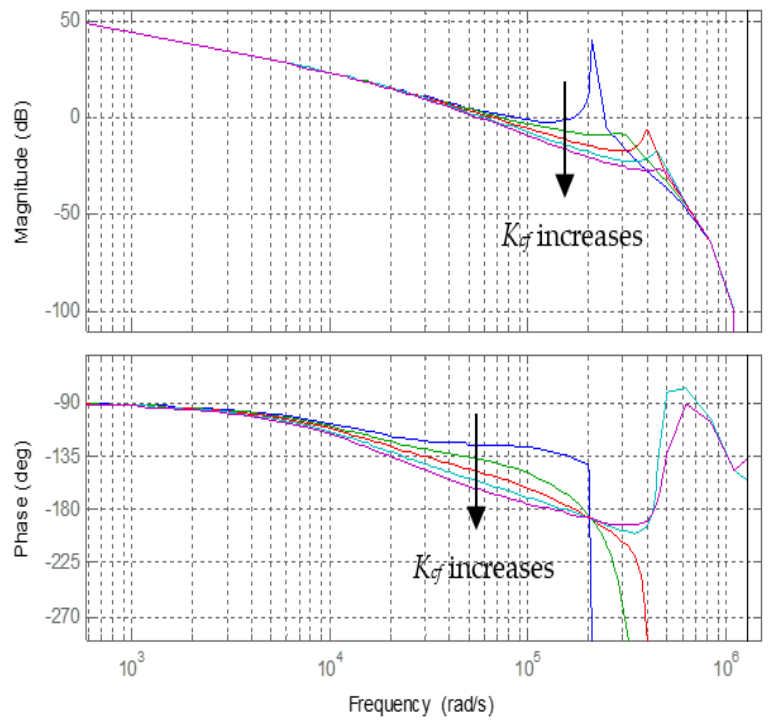
Figure 12. Open ‐ loop Bode plot with different active damping gain K cf .